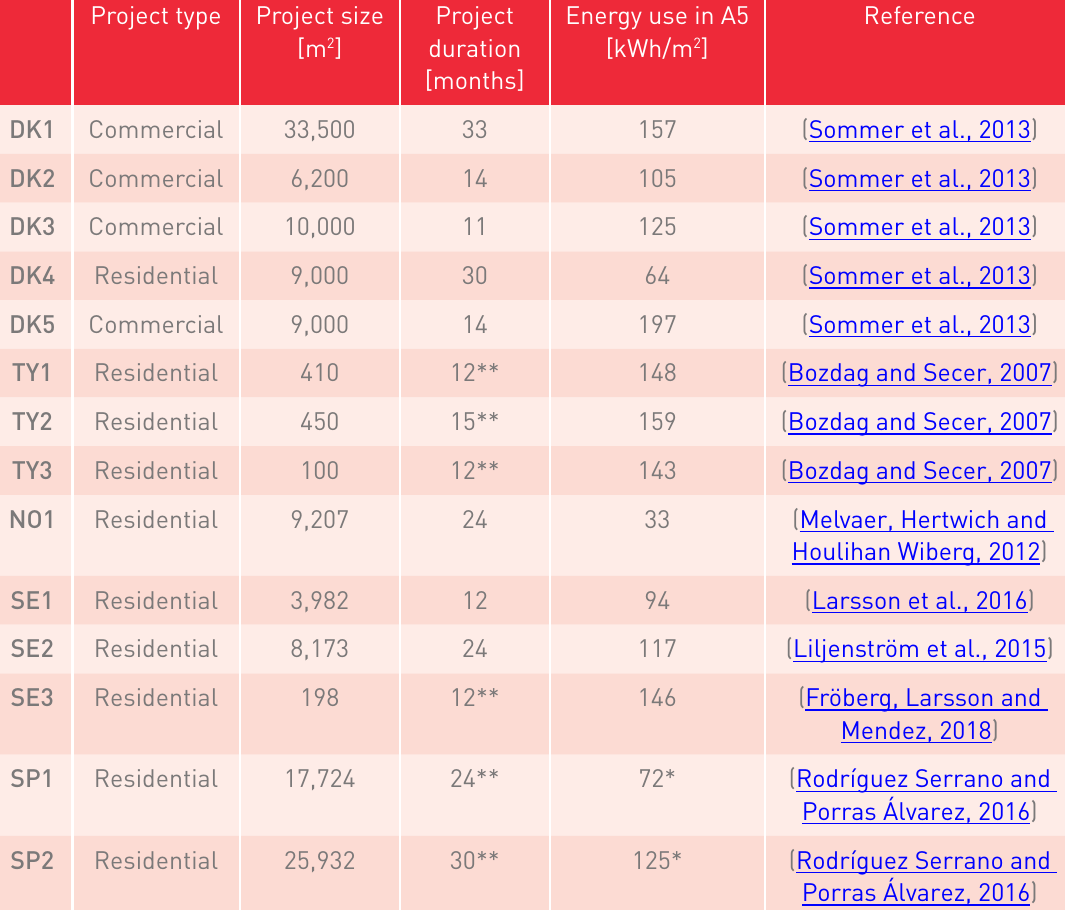
Case studies with dedicated values for